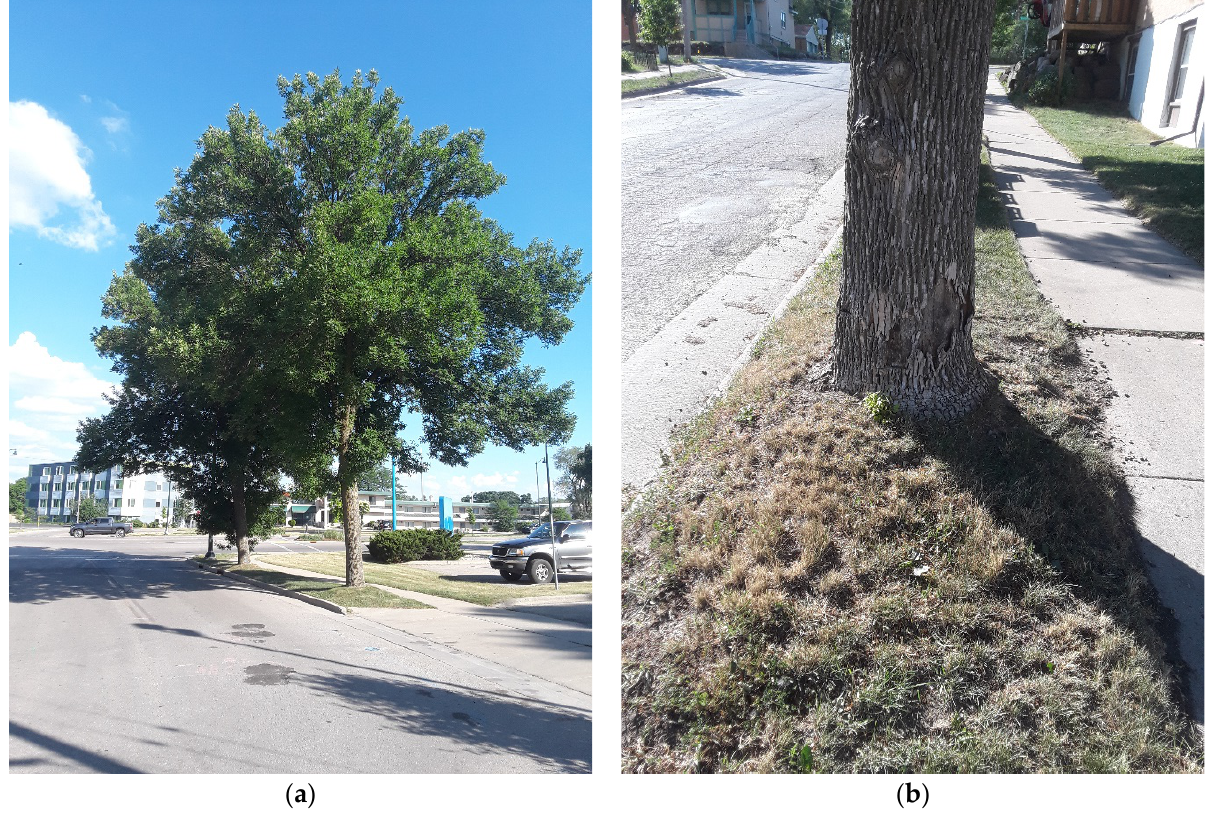
Figure A1. Example street setting of green ash trees from used in this study from a (a) distance and (b) closeup.